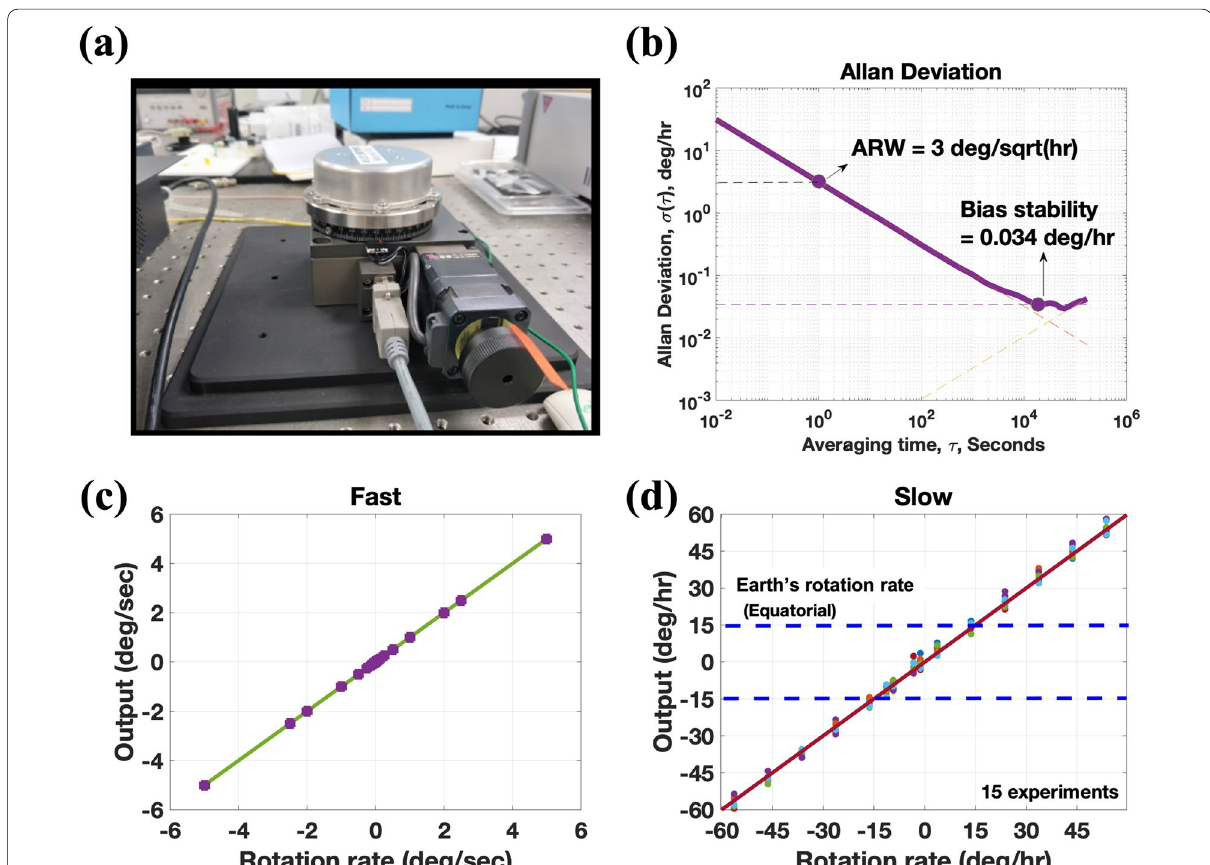
Fig. 1 a The physical picture of the NCU‑FOG. b The Allan deviation analysis, which shows our FOG has a bias stability of 0.034 deg/h and an ARW of 3 deg/sqrt(h). c Relatively fast and d ultra‑low rotational response characteristics, plotted with data from 15 independent measurements (represented by different colors). The solid lines shown in c and d are the flitted results with a linear scaling